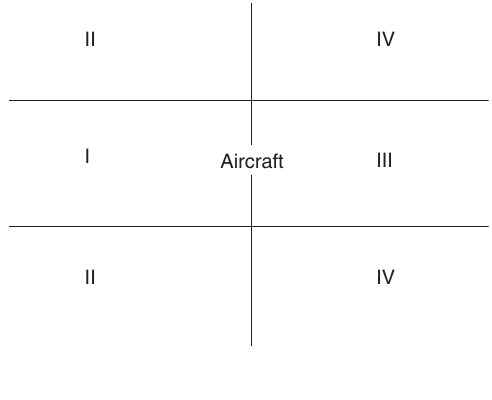
Figure 2 | Categories for data analysis. Category I: inside the flight track, ahead of the aircraft. Category II: outside the flight track, ahead of the aircraft. Category III: inside the flight track, behind the aircraft. Category IV: outside the flight track, behind the aircraft.